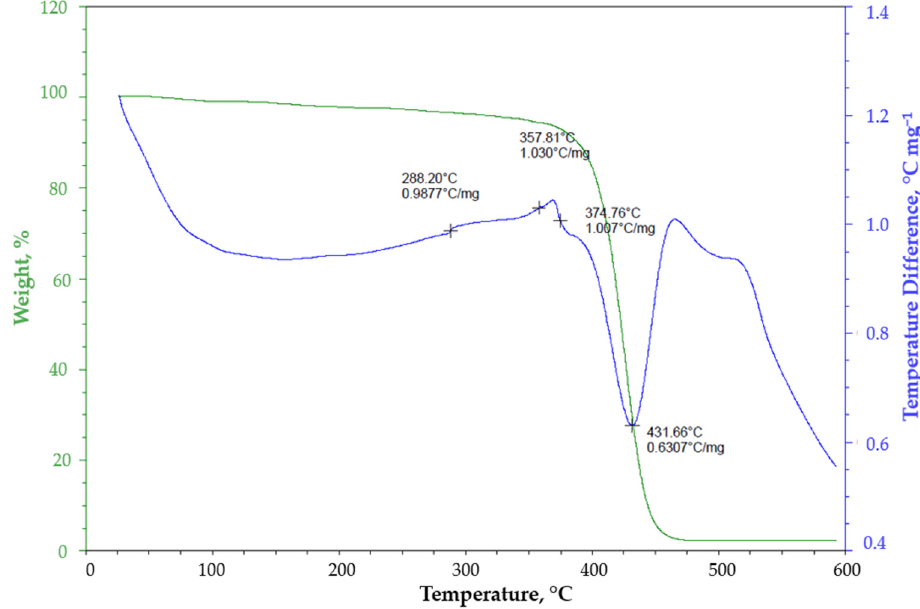
Figure 2. EPS TGA curve at a heating rate of 20 °C min − 1 . Measuring points (+).